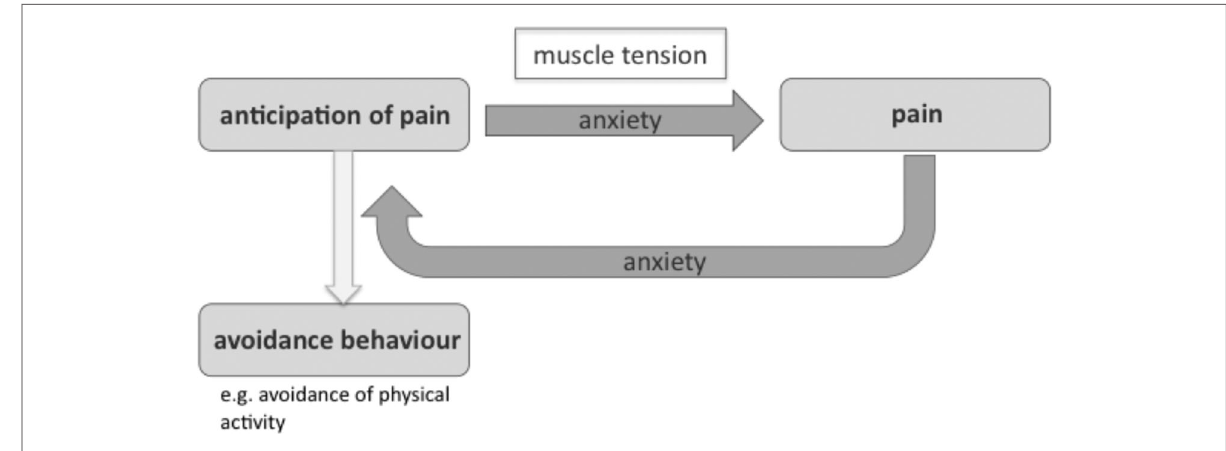
FIGURE 1 Anxiety loop of